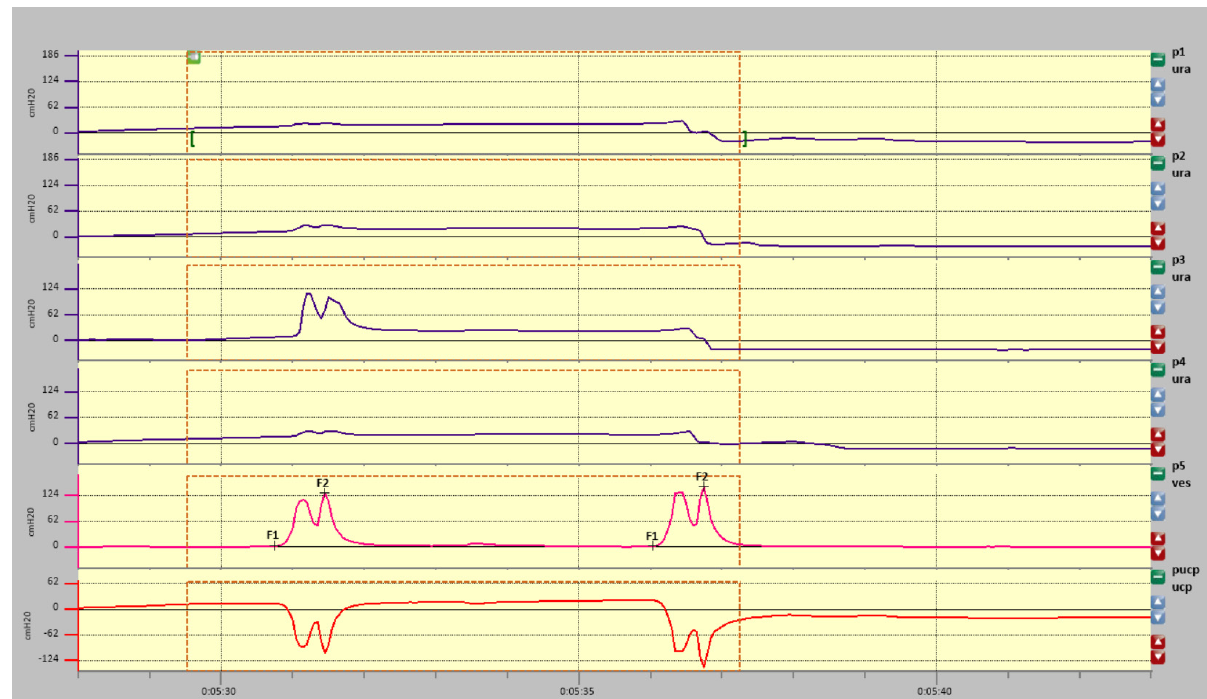
Figure 7. Stress profilometry.